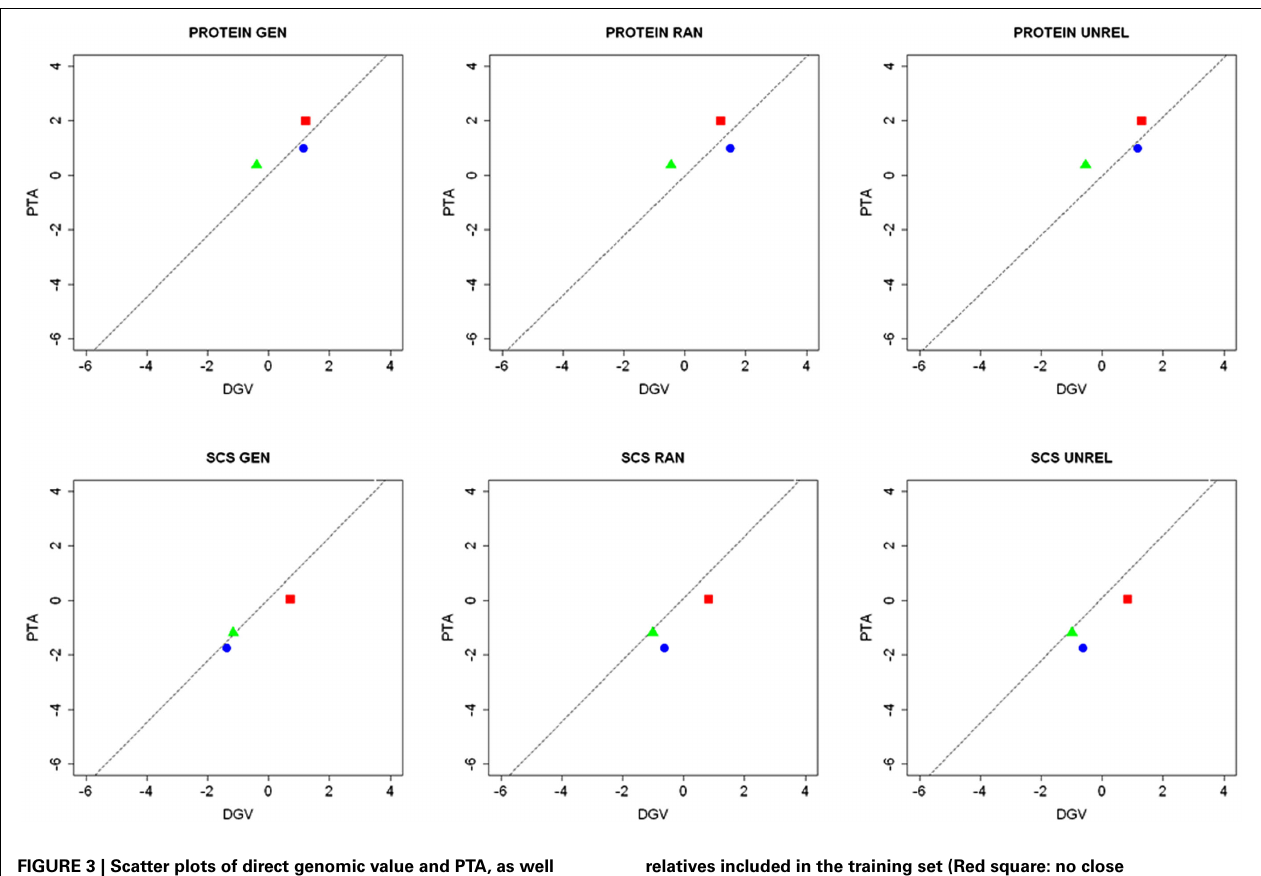
FIGURE 3 | Scatter plots of direct genomic value and PTA, as well as the regression line (dashed line), for three testing sires common in all the layouts, which differed in the number of